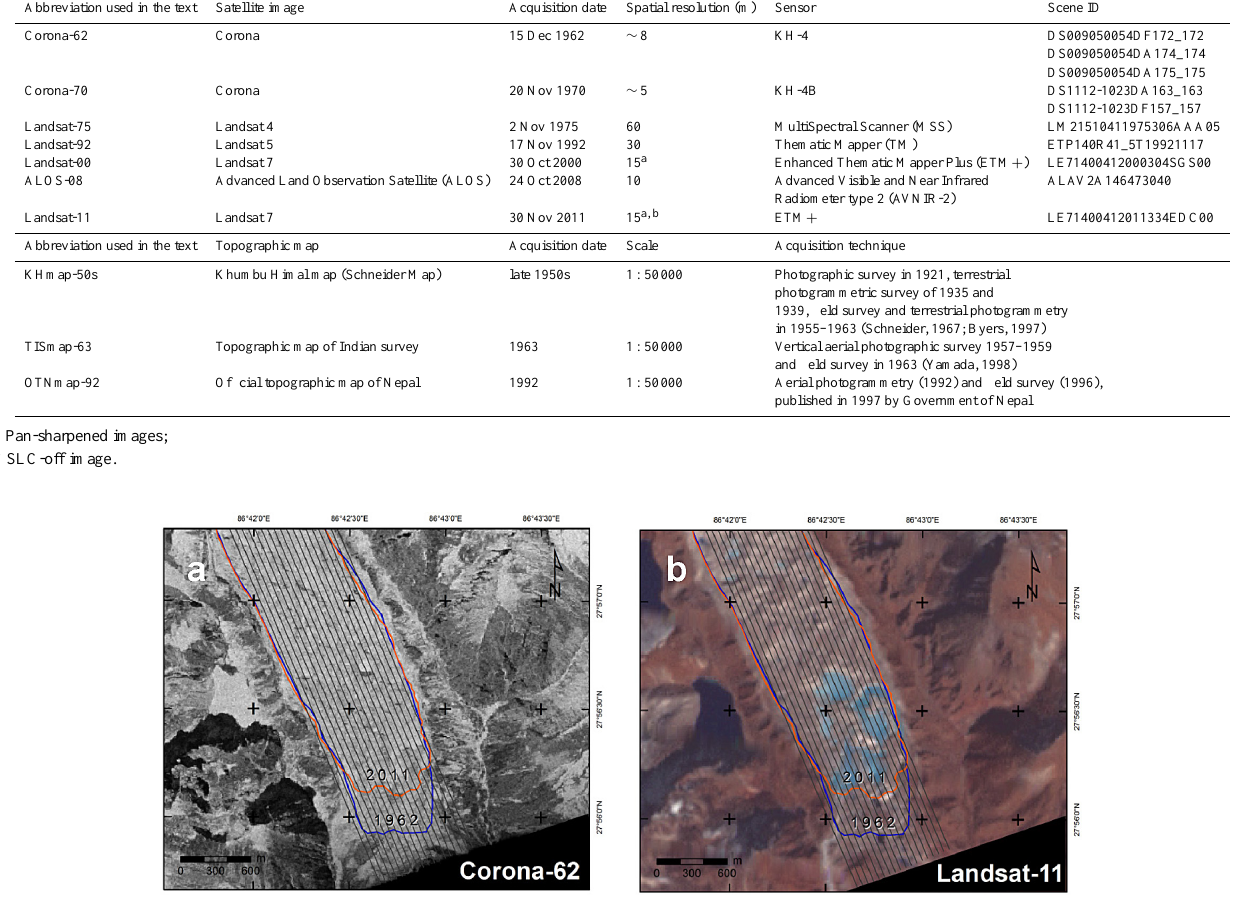
Figure 2. Glacier delineation in (a) panchromatic Corona-62; (b) SLC-off gap filled Landsat-11. The stripes in the images are meant for mean length change